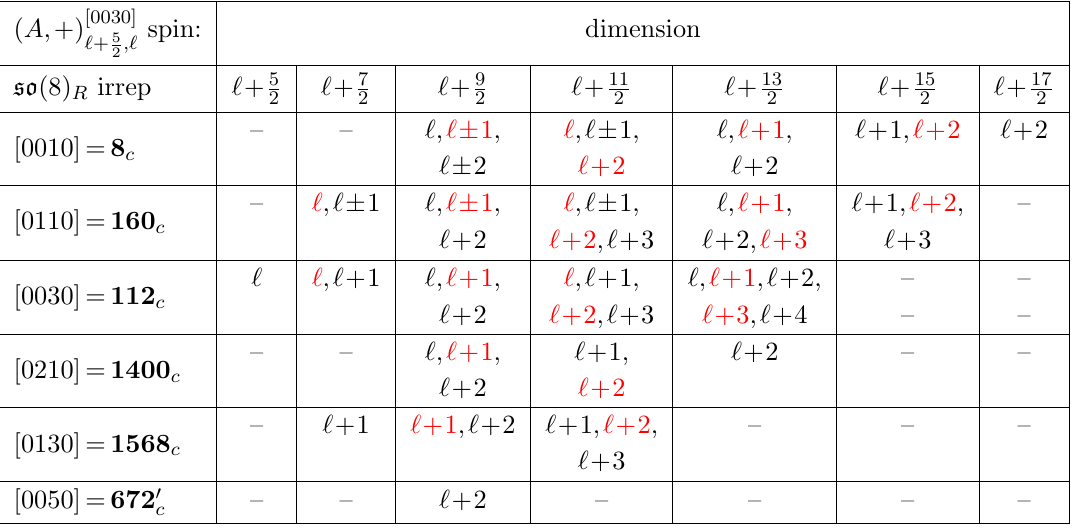
Table 16 . All possible conformal primaries in S 2 (cid:2) S 3 corresponding to the ( A; +) [0030] formal multiplet. For ‘ = 0, the conformal primaries with negative spin should be